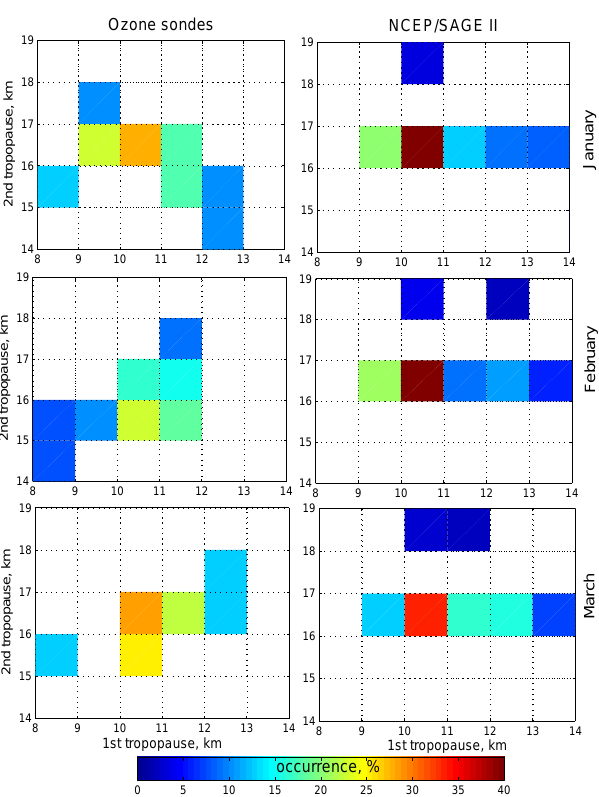
Fig. 4. Statistics of double tropopauses at 30 ◦ –40 ◦ N in January– March, as obtained from the temperature measurements taken as part of ozonesonde flights (left) and the NCEP reanalysis at the lo- cations of the SAGE-II